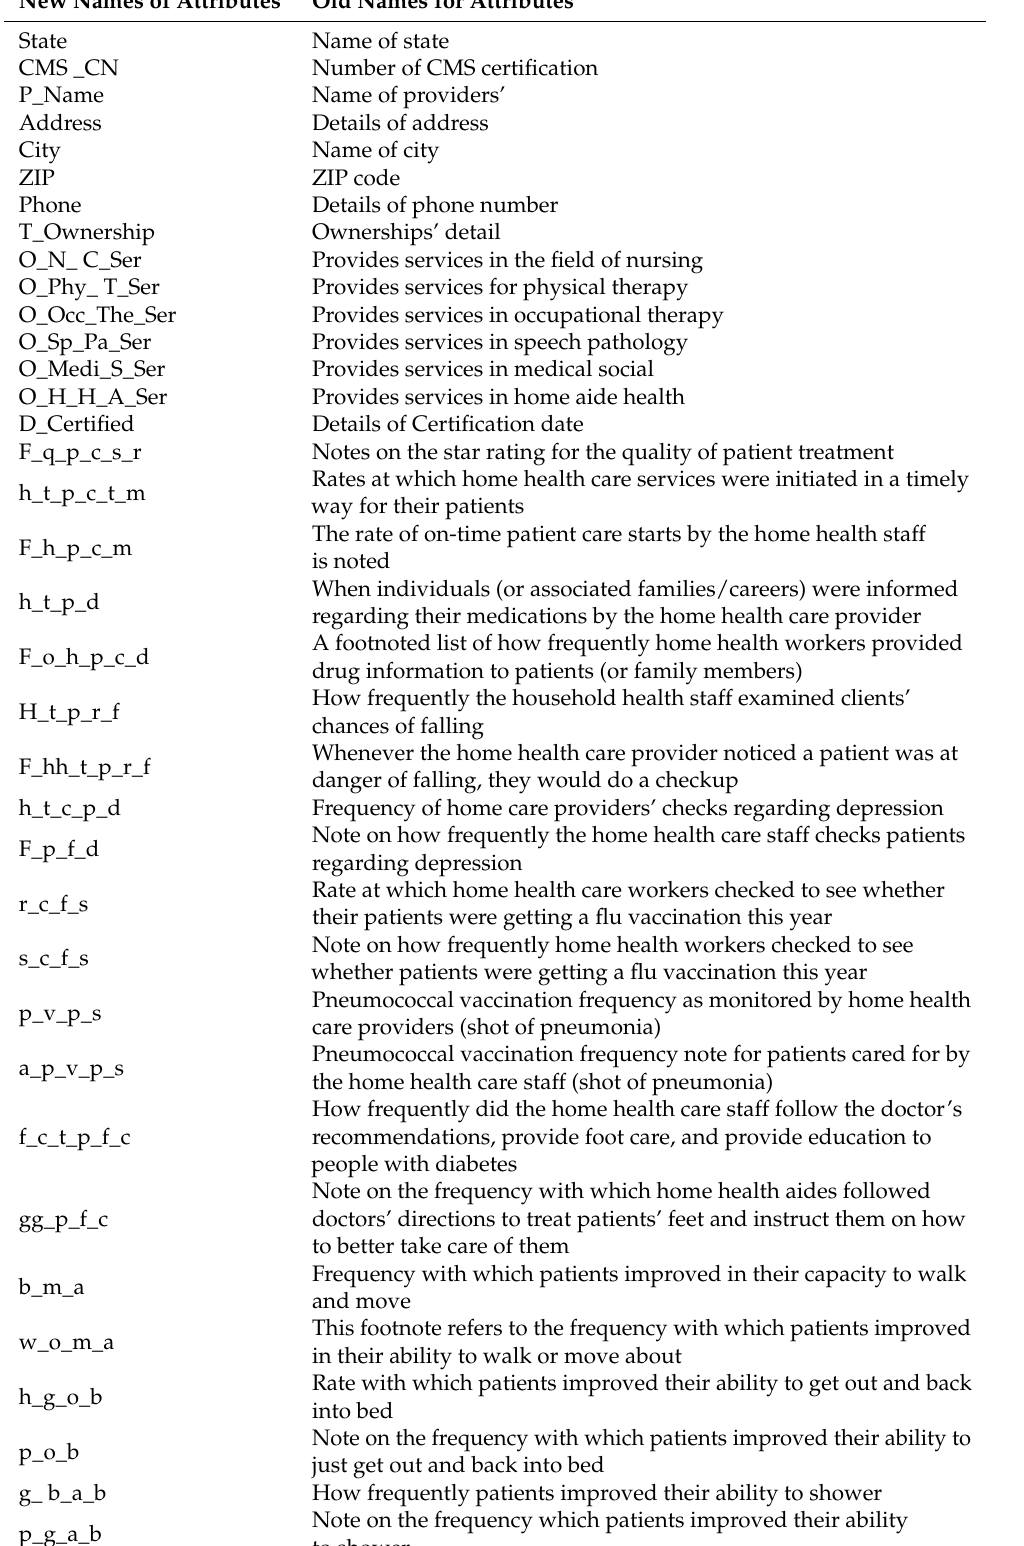
Table 1. HHCA dataset attributes’